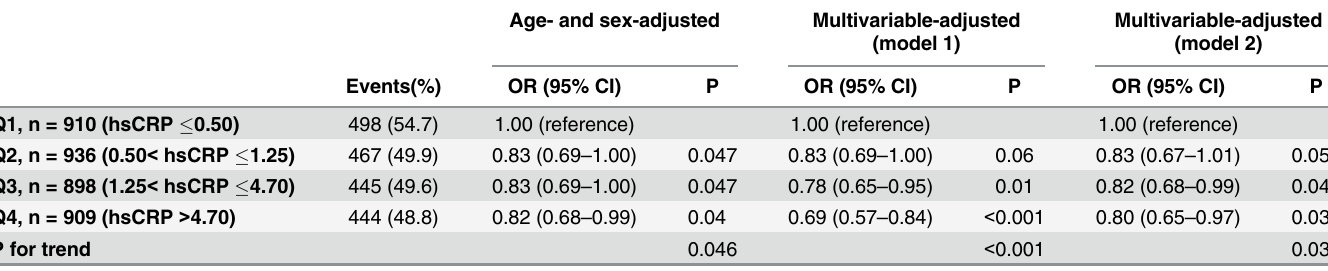
Similarly, higher levels of plasma hsCRP were significantly associated with an increased risk of neurological deterioration even after adjusting for multiple confounders (Table 3). The plasma hsCRP levels showed a significant association with poor functional outcome at discharge and at 3 months (Table 4). Table 2. Plasma hsCRP levels and neurological improvement during